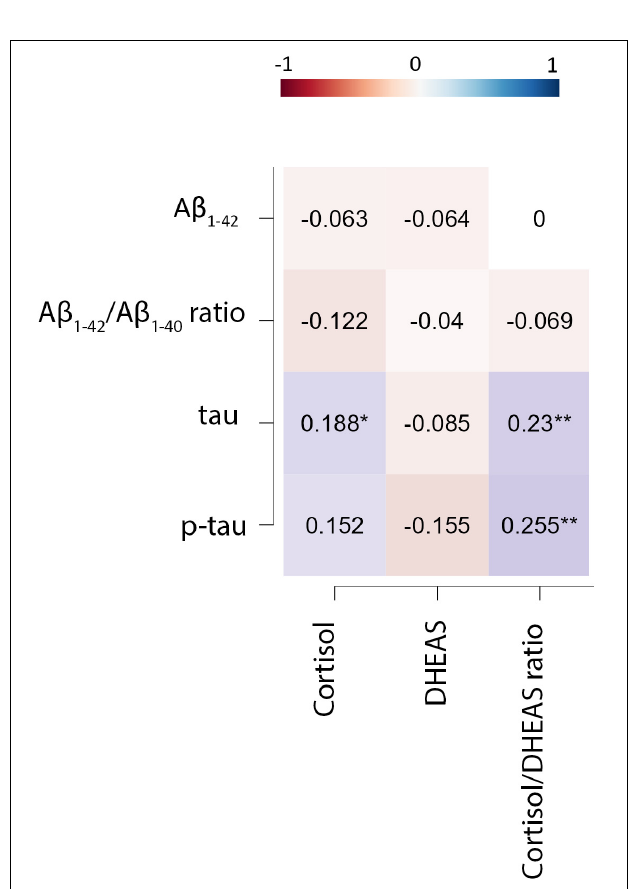
FIGURE 3 | Partial Spearman’s correlations between cerebrospinal fluid cortisol and regional brain volumes (adjusted for age and sex). There were significant negative partial correlations between baseline cerebrospinal fluid cortisol levels and the volumes of the amygdala, and the insula (adjusted for sex and